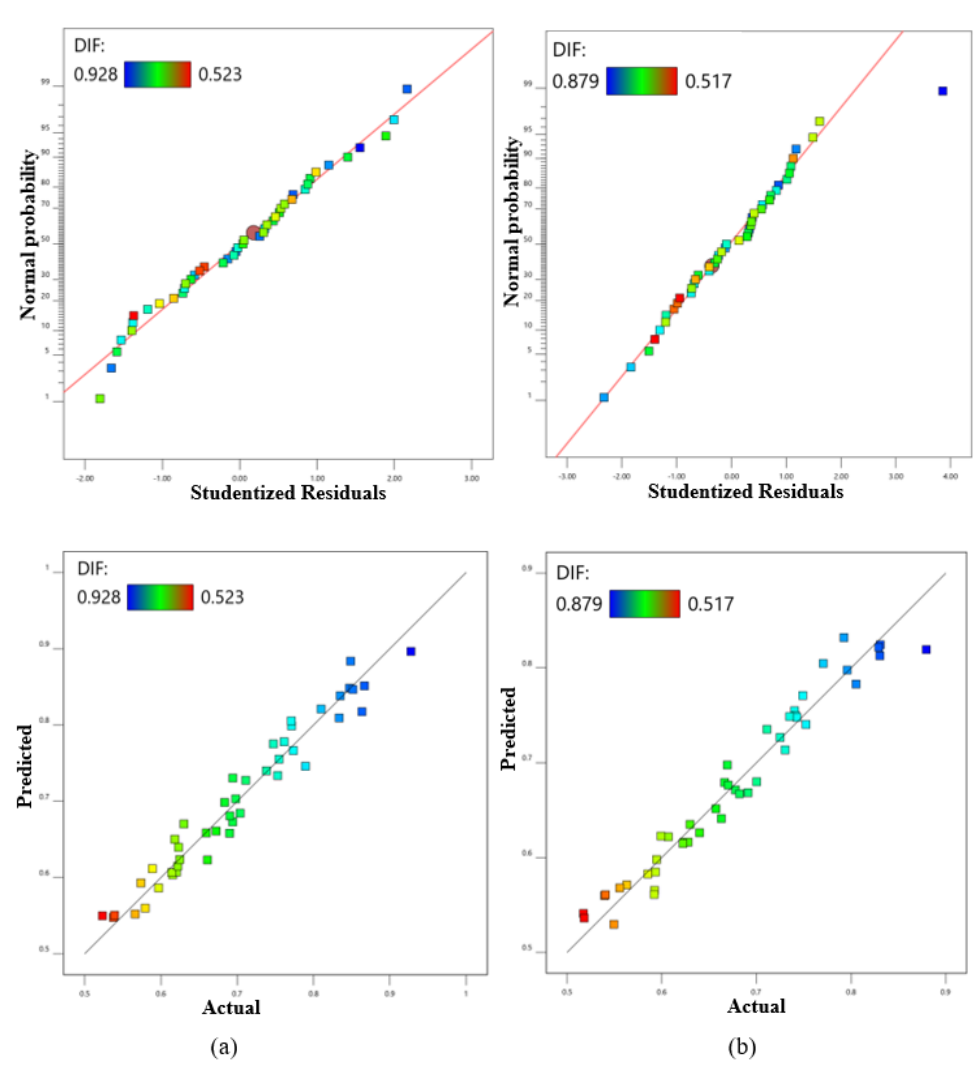
Figure 12. Plots of normal probability and predicted vs. actual values: ( a ) PC and ( b ) HVFANS